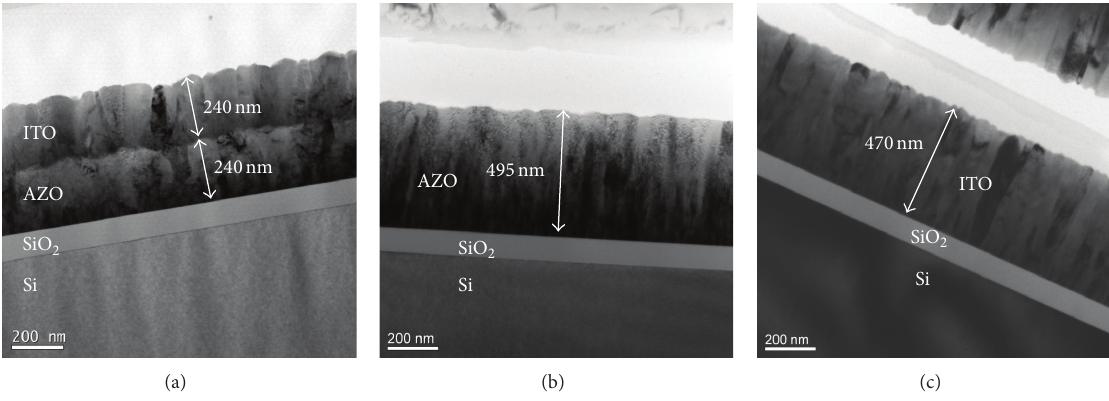
Figure 4: Low-magnification TEM images of (a) ITO/AZO, (b) AZO, and (c) ITO films [2].